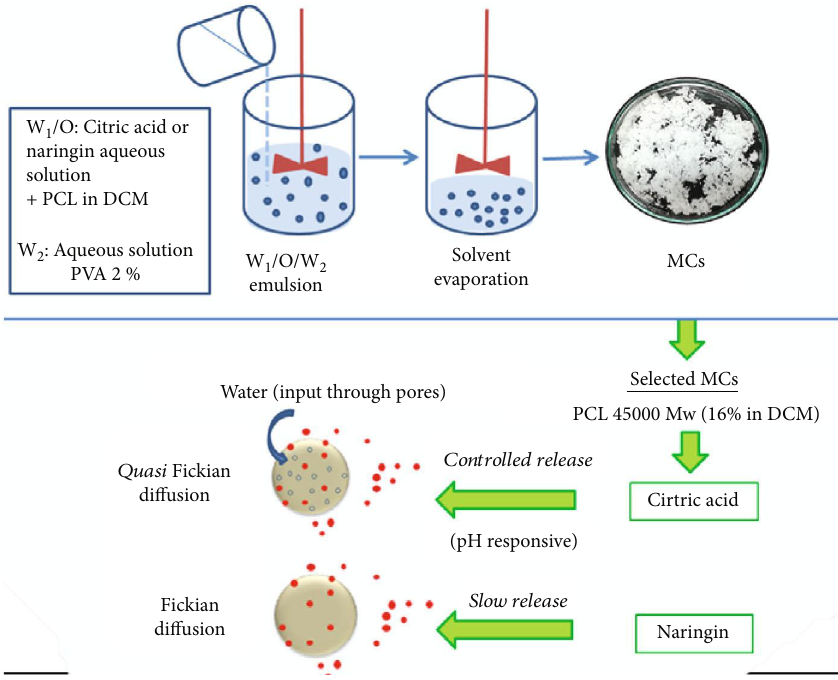
Figure 44: Citric acid and naringin microencapsulation: new strategy for sustainable agriculture